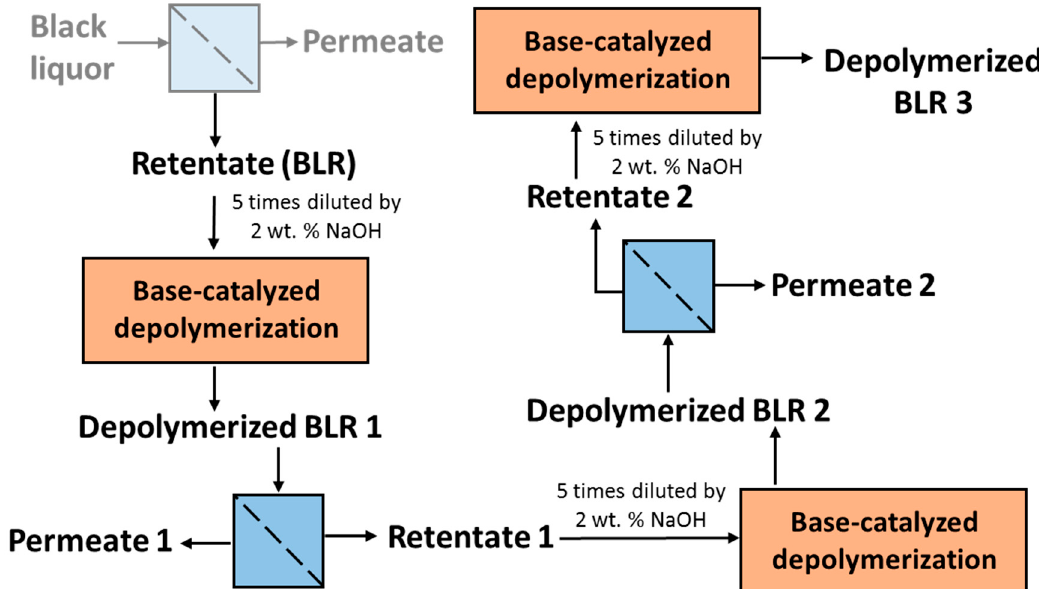
Figure 1. Schematic diagram of the experimental setup (Base-catalyzed depolymerization conditions: 170–210 °C, 2 min of residence time, 130 bar; membrane filtration conditions: 50 °C and 5.5 bar).